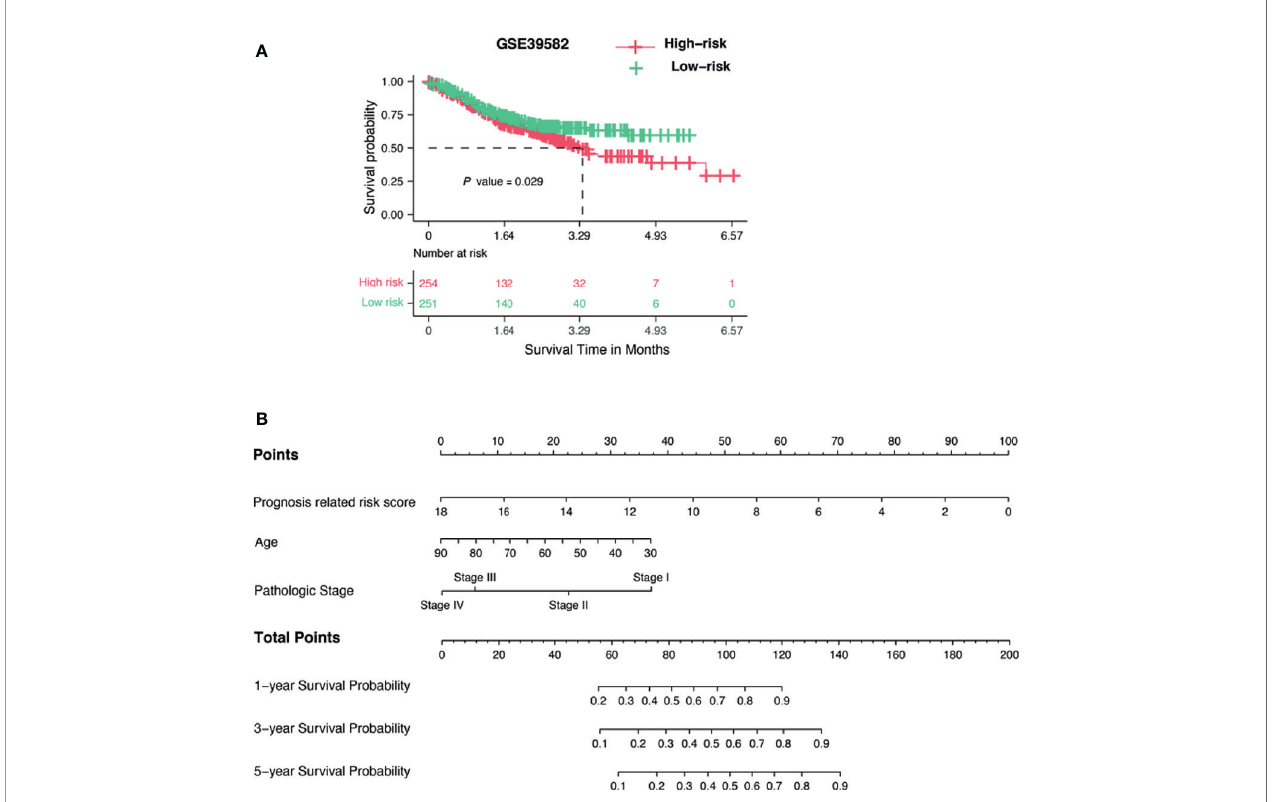
FIGURE 5 | Validation of GlycoSig and nomogram for pro fi cient mismatch repair (pMMR) colorectal adenocarcinoma (CRAC). (A) Independent validation of GlycoSig in the GSE39582 set; Kaplan – Meier survival curves of patients classi fi ed into high- and low-risk groups using the GlycoSig for overall survival. (B) Nomograms to predict 1-, 3-, and 5-year survival probability in pMMR